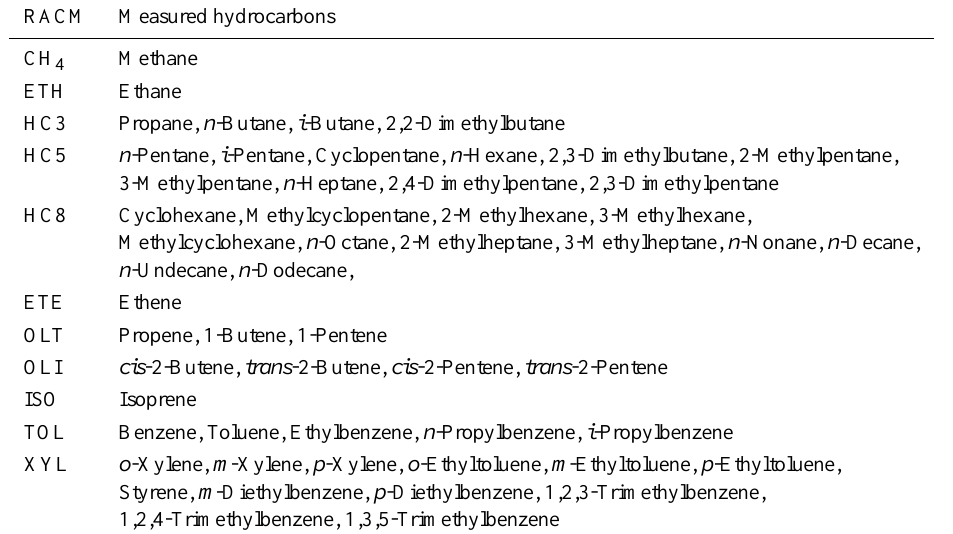
Table 2. Measured hydrocarbons and their assignment to RACM